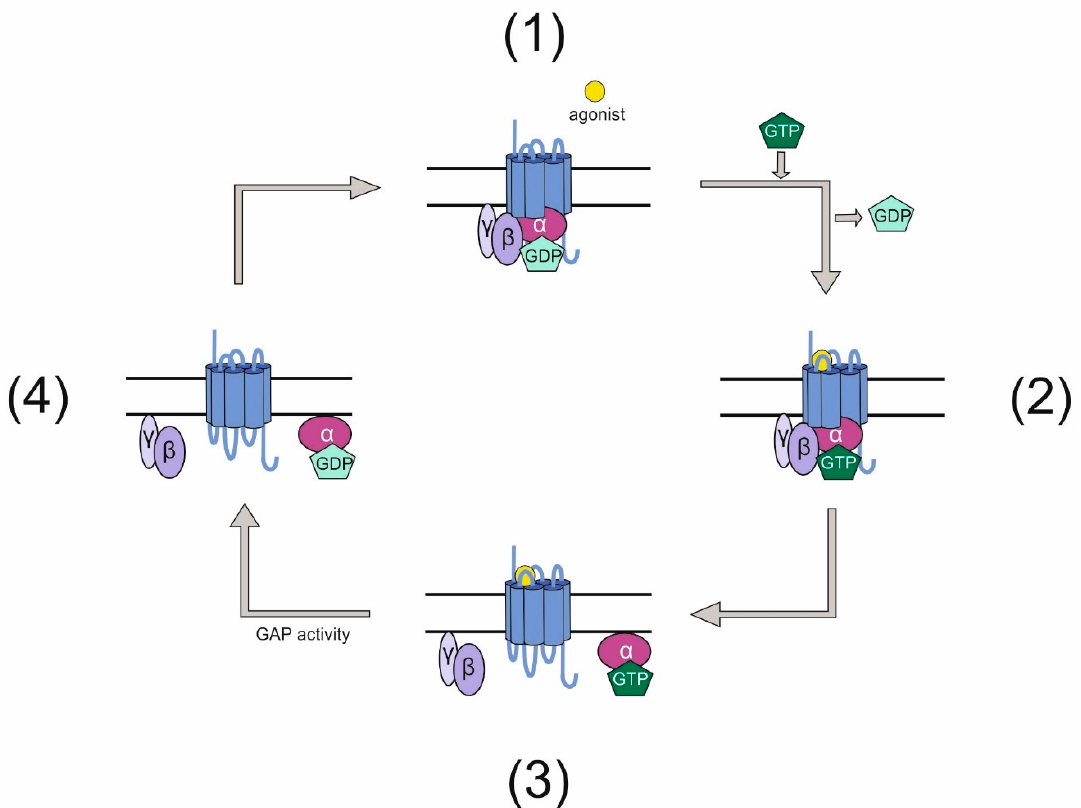
Figure 1. Classical G-protein cycle. (1) An inactive GPCR is associated intracellularly with a heterotrimeric G protein. This G protein has bound GDP on its G α subunit. (2) Upon activation of the GPCR by an agonist, the receptor acts as a GEF for the G protein and exchanges GDP for GTP. (3) The active G protein dissociates into G α and a G βγ complex, both of which can mediate signals. (4) After signals have been elicited, the GTP bound to G α is hydrolyzed rendering the G protein inactive. The G protein subunits re-associate and bind the GPCR.